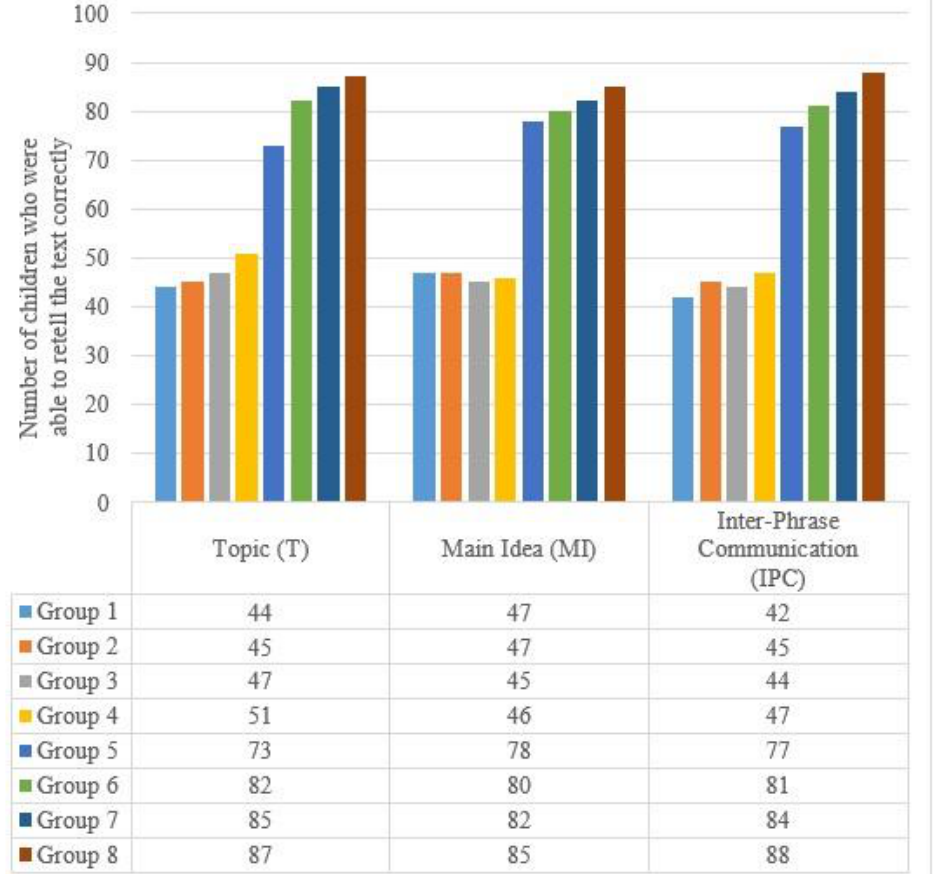
Figure 1 . Results of the analysis of senior preschoolers’